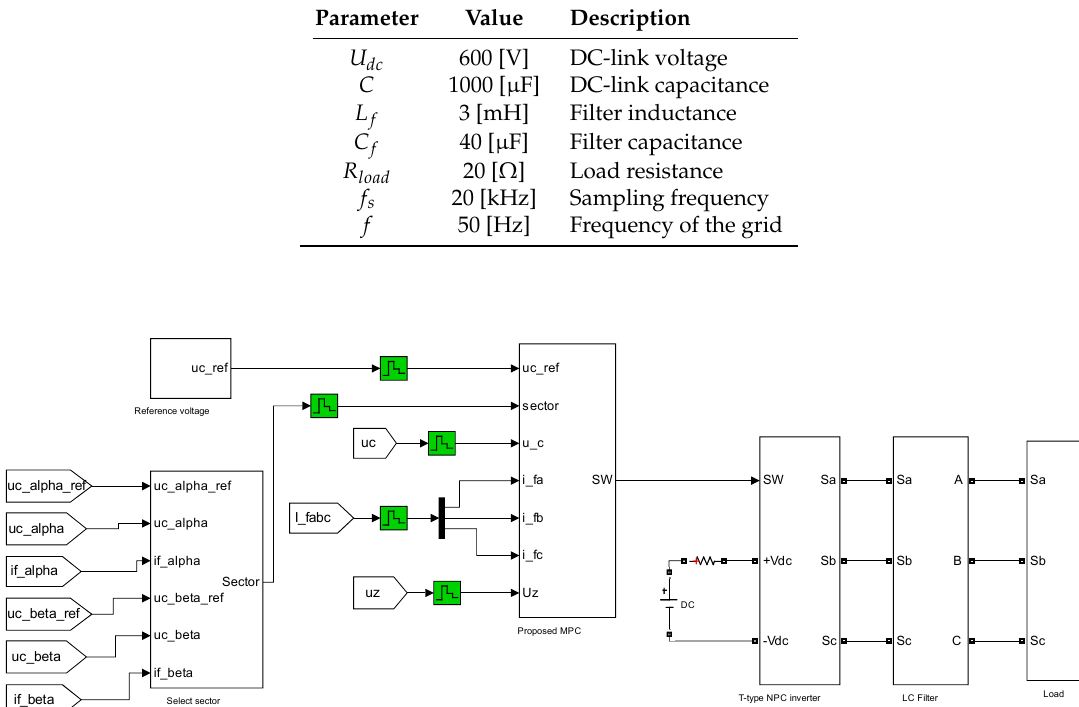
Figure 5. Block diagram of the proposed strategy in